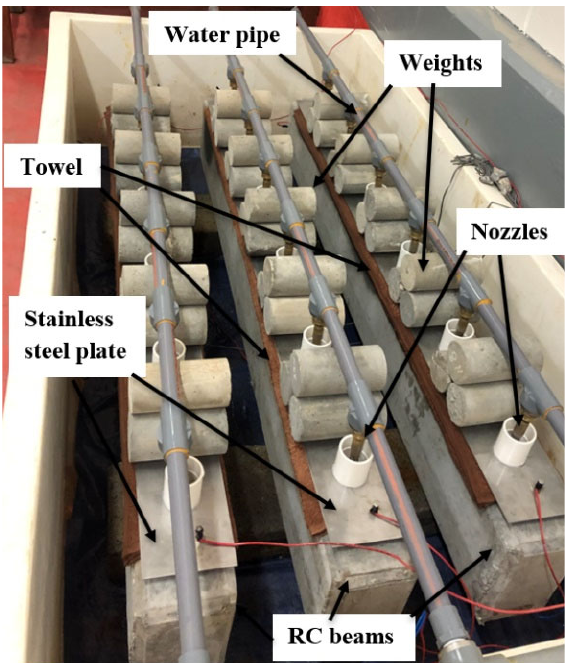
Figure 4. RC beam specimens under accelerated reinforcement corrosion using developed